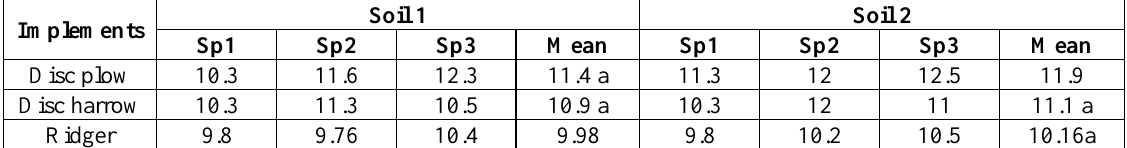
Table 4. Effect of different forward speeds and soil on Implement draft force (kN) at the different soils Soil 1 Implements